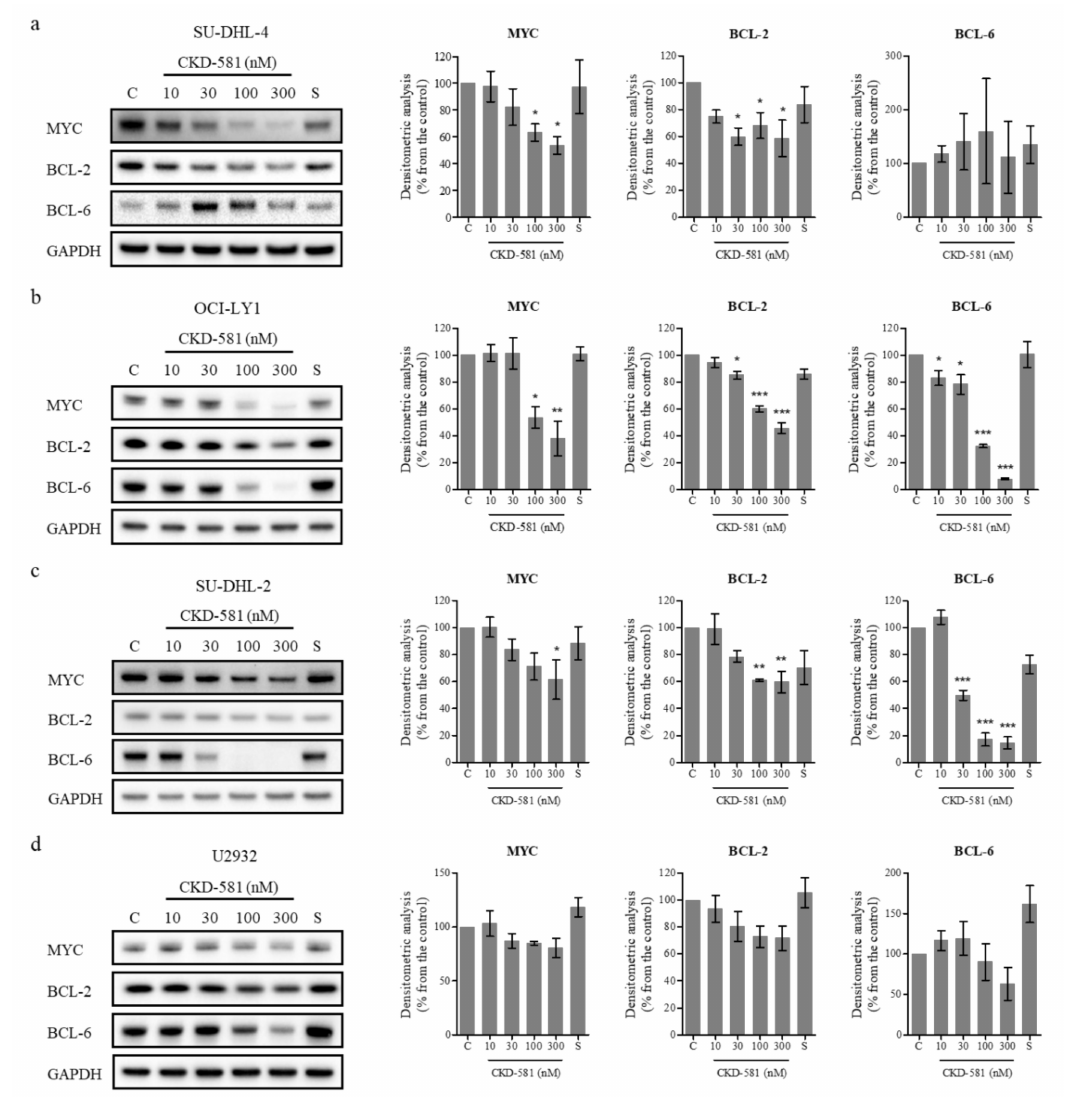
Figure 2. CKD-581 reduces the protein expression of prognostic markers for DLBCL. ( a ) SU-DHL-4, ( b ) OCI-LY1, ( c ) SU-DHL-2, and ( d ) U2932 cells were treated with vehicle control (C), various concentrations (10–300 nM) of CKD-581, or 300 nM SAHA (S) for 24 h, and total cell lysates were subjected to immunoblotting for MYC, BCL-2 and BCL-6. Data represent mean ± SEM of at least three independent experiments ( n = 3, significant vs. control; * p < 0.05, ** p < 0.01, *** p <